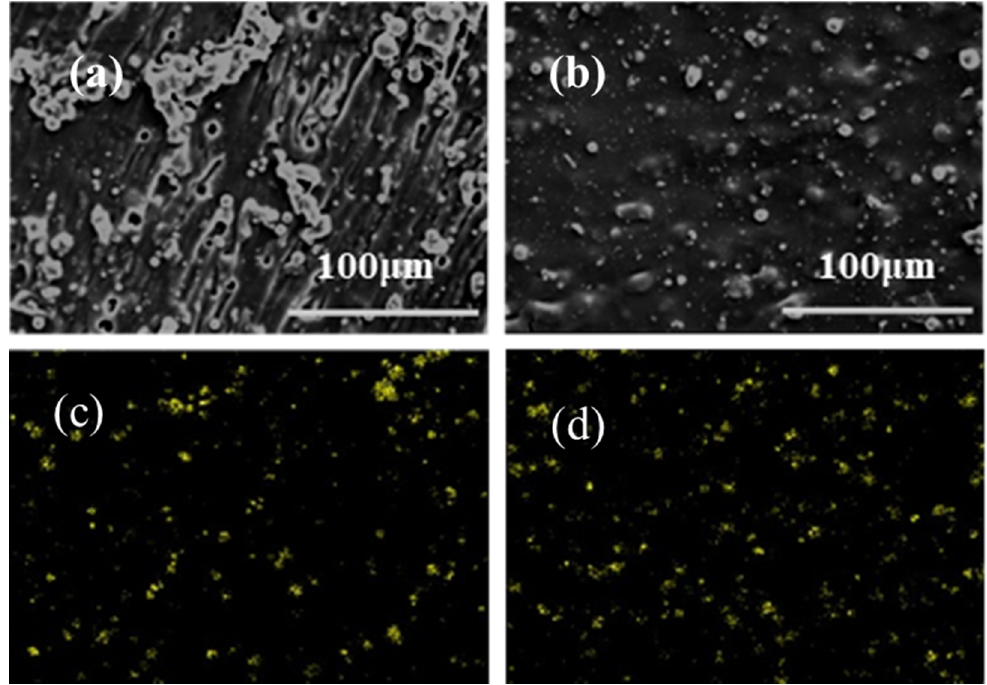
Figure 7. SEM morphology of composites filled with ( a ) 30 wt% Al 2 O 3 , ( b ) 30 wt% PDA-Al 2 O 3 , EDS element distribution of yellow spots in ( c ) 30 wt% Al 2 O 3 / PU, and ( d ) 30 wt% PDA-Al 2 O 3 / PU.